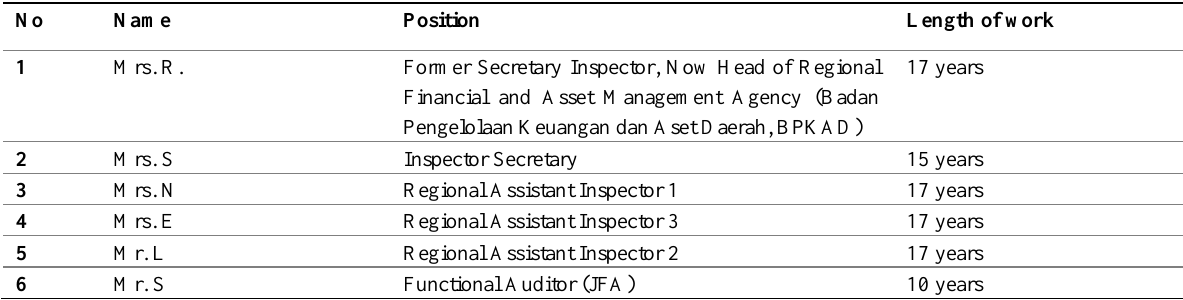
Table 1: List of